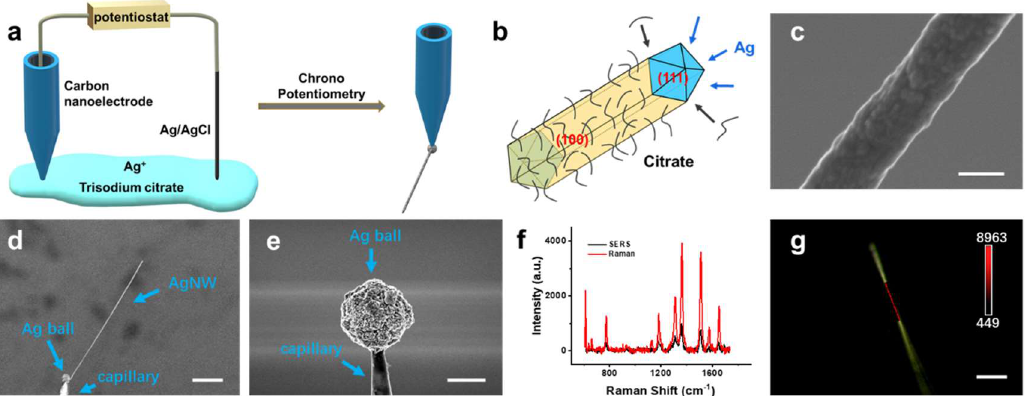
Figure 1. ( a ) Schematic diagram for the synthesis of single AgNWs by an electrochemical method. ( b ) Schematic diagram for the mechanism underlying the unidirectional growth of AgNWs. ( c ) ( d ) SEM images of an AgNW. ( e ) SEM image of the Ag ball at the carbon nanoelectrode tip. ( f ) SERS spectrum (black) of 10 −9 M R6G on an AgNW and Raman spectrum (red) of 10 −3 M R6G. ( g ) SERS mapping of a single AgNW modified with 4-MBN. Scale bars: ( c ) 200 nm; ( d ) 20 μm; ( e ) 2 μm; ( g ) 20 μm.